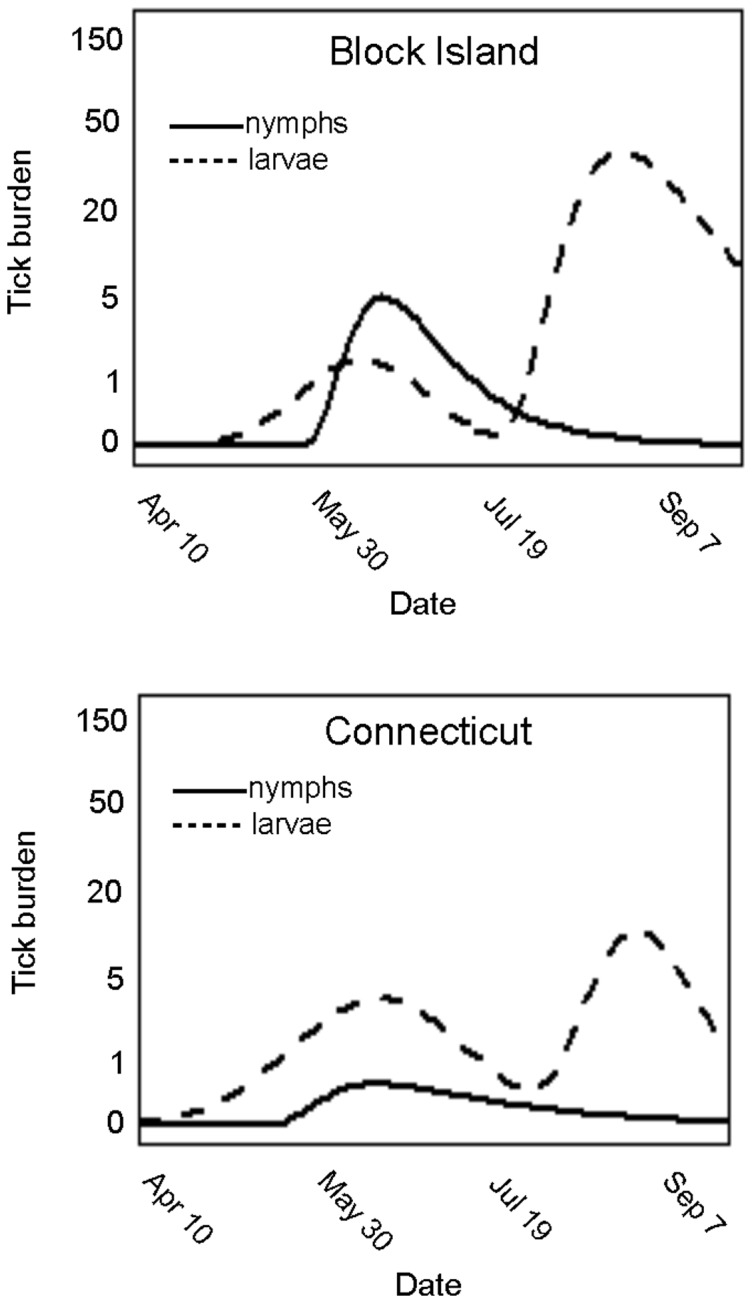
Larval and nymphal tick burdens on Peromyscus leucopus expressed as mean tick count per mouse.Tick burdens are presented as best fit curves to field derived data from Block Island, RI (top) and Connecticut (bottom) sampled populations (S2 Fig.).